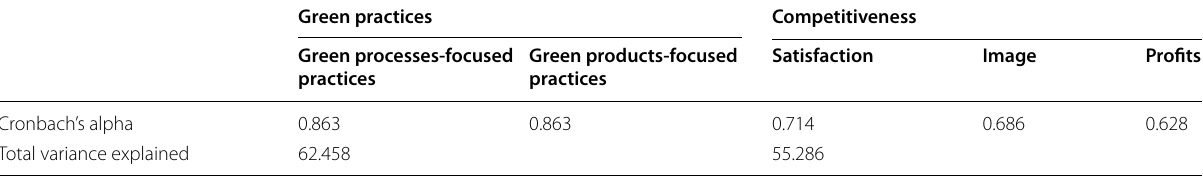
Table 1 Reliability and factor analysis results